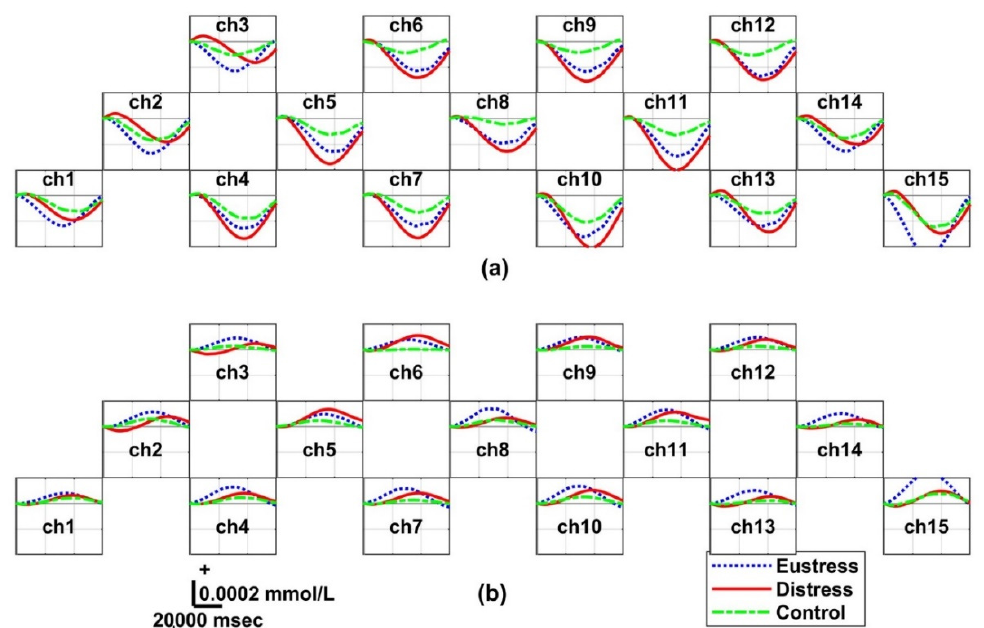
Figure 7. Grand averaged temporal hemodynamic oscillations within the interval of each epoch in Session 2 for the eustress, distress, and control groups: ( a ) oxygenated hemoglobin ( Δ HbO) and ( b ) reduced hemoglobin ( Δ HbR). The blue dotted, red, and green dotted lines correspond to the eustress, distress, and control groups, respectively. These data show the highest brain oscillation in the distress group, followed by the eustress group and control groups.